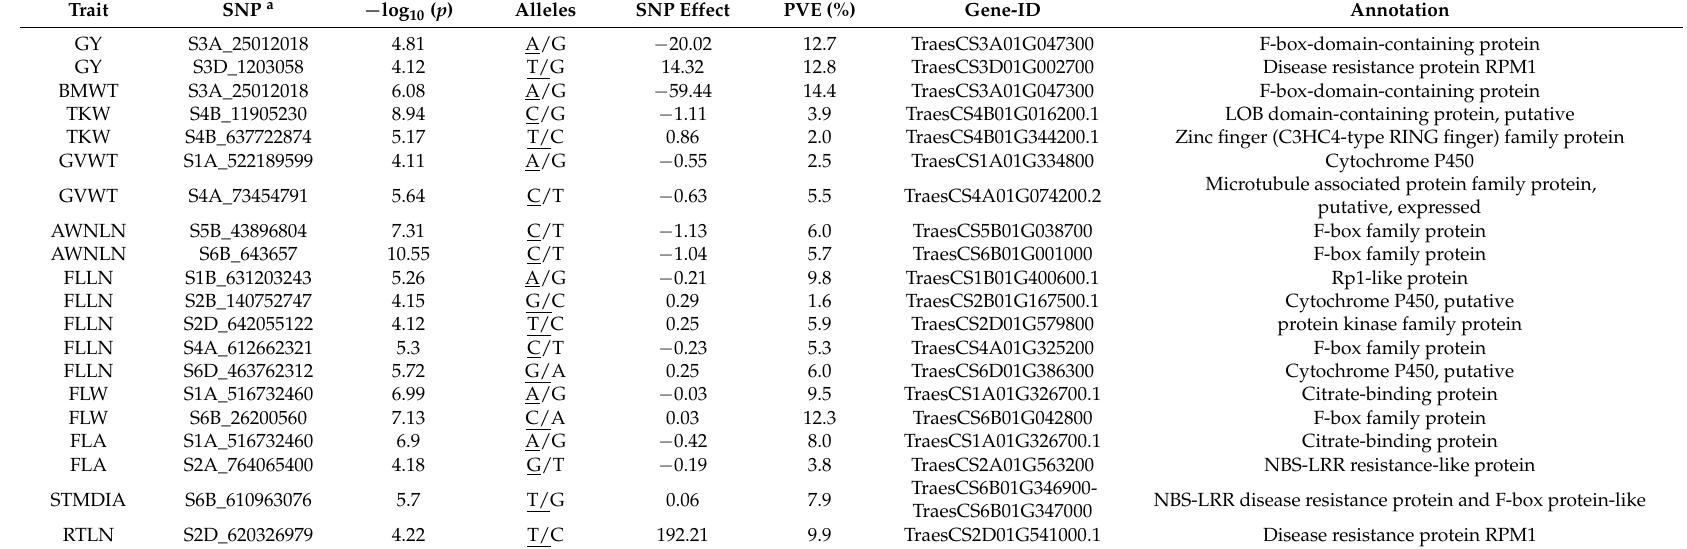
PVE: phenotypic variance explained; GY, grain yield; HI, harvest index; BMWT, biomass weight; TKW, thousand kernel weight; GVWT, grain volume weight; AWNLN, awn length; FLLN, flag leaf length; FLW, flag leaf width; FLA, flag leaf area; STMDIA, stem diameter; RTLN, root length. a S+chromosome_chromosome position in